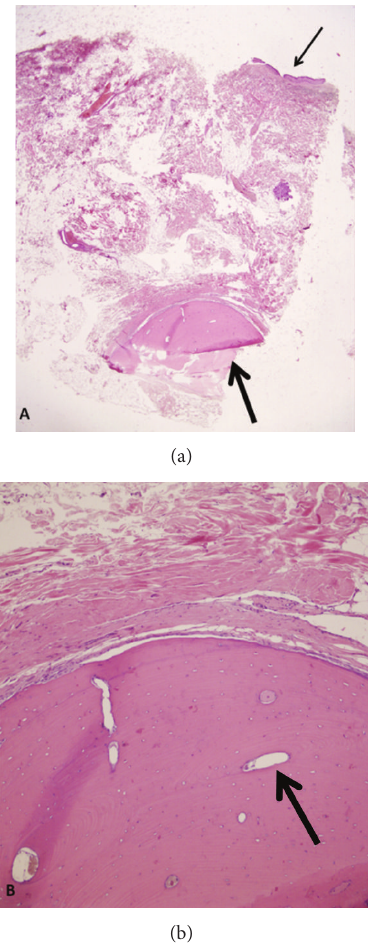
Figure 3: (a) Conjunctival epithelium (thin arrow) and het- erotrophic osseous tissue (left thick arrow) (HEx20); (b) osseous tissue-like compact bone and Haversian canals (HEx200) (right thick